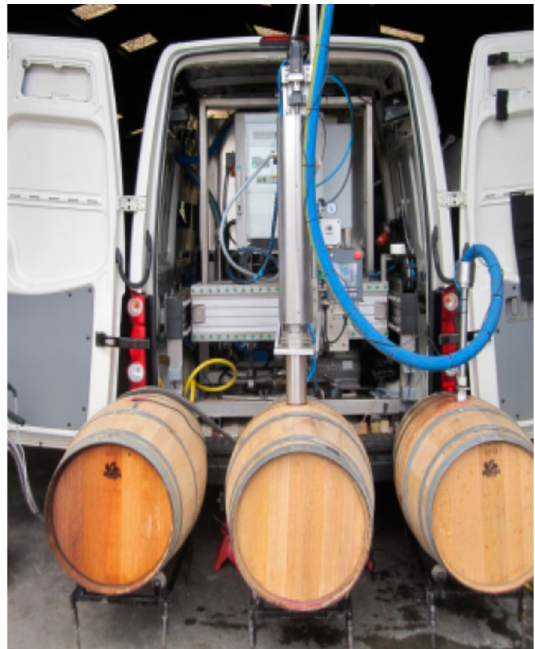
Figure 1. High power ultrasound (HPU) apparatus.